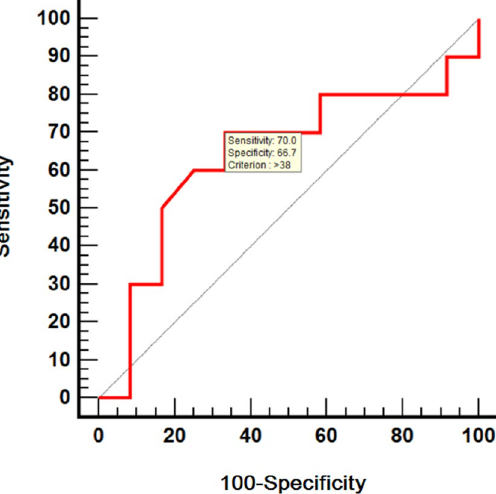
Figure 2. Receiver operating characteristic curves for coronary wedge pressure in predicting left ventricular end-systolic volume ≥ 75 ml at 60 months follow-up. AUC = area under the